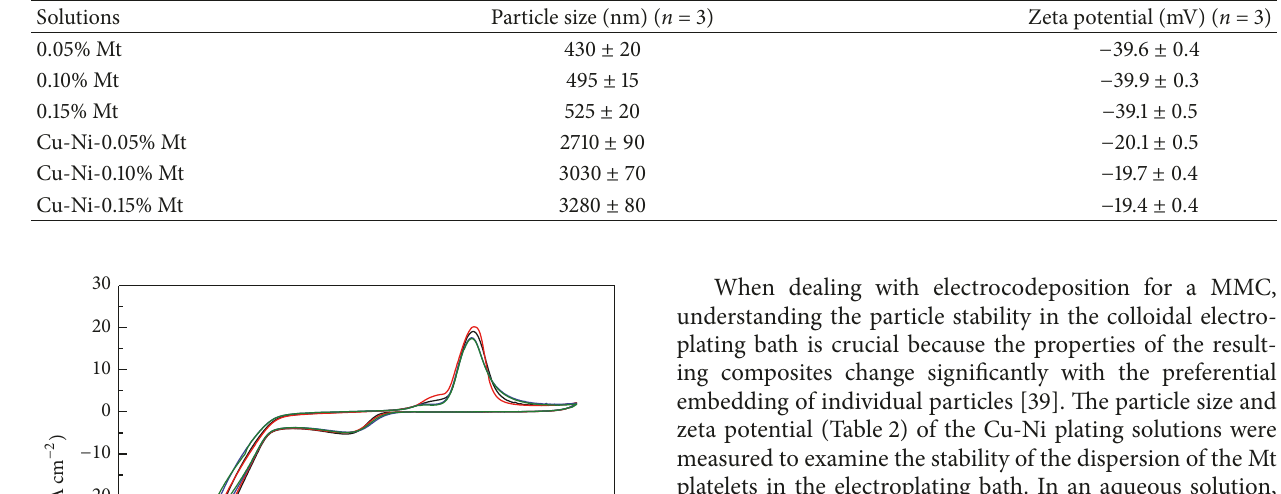
Table 2: Particle size and zeta potential for Mt solutions and 90-10 Cu-Ni-Mt plating solutions.